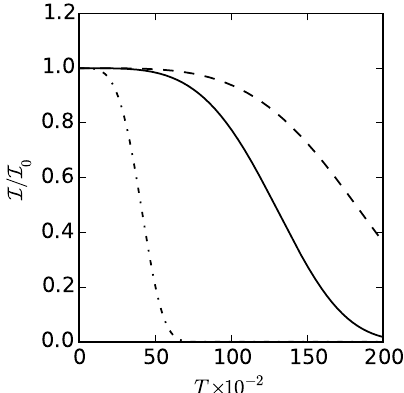
Figure 6. The signal visibility, i.e. , the decaying envelope that limits the maximum possible signal strength for a given interferometer time T . The decay is proportional to exp ( − β 2 ) , causing rapid signal loss for even small residual potentials. Here we show β = 5 × 10 − 13 (dashed), 10 − 12 (solid), and 10 − 11 (dash-dot). T × 10 − 2 corresponds roughly to 1